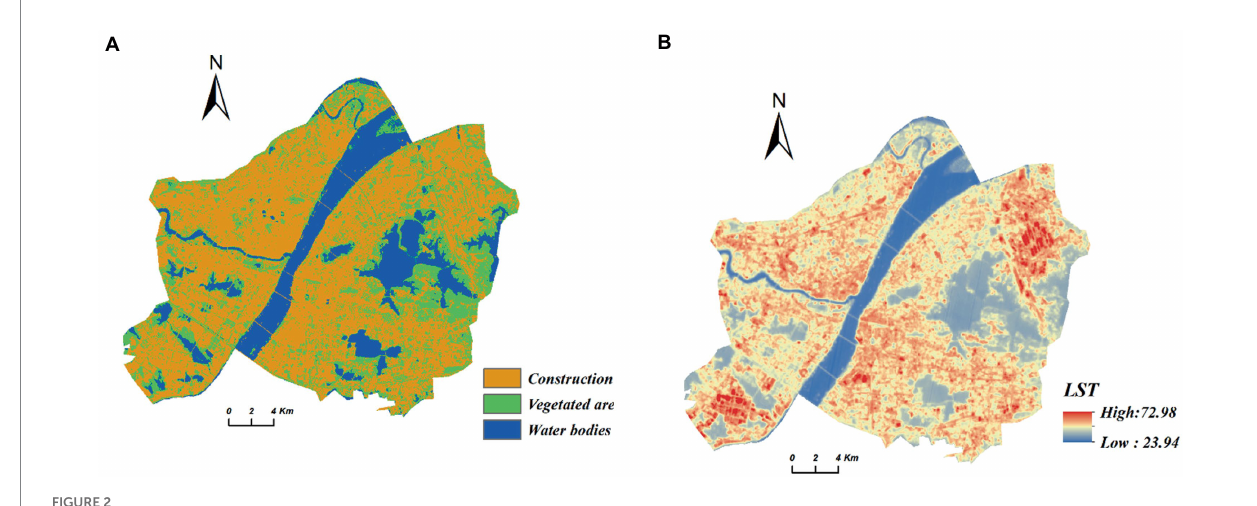
FIGURE 2 Spatial distribution maps of (A) LULC types and (B) LST